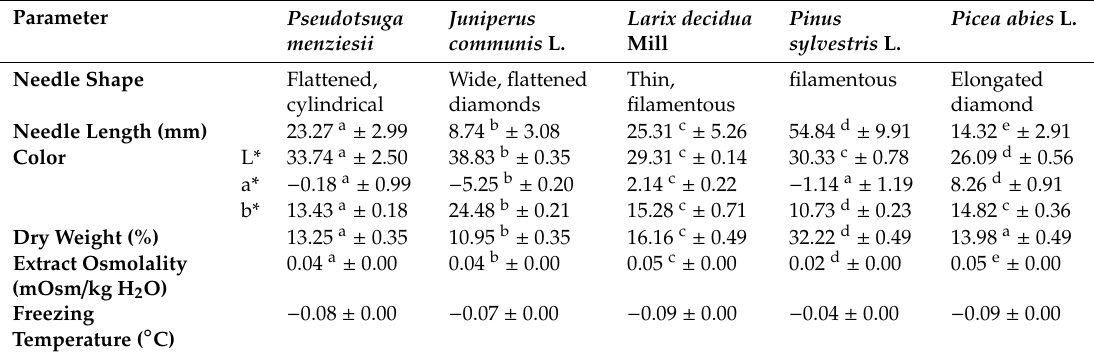
Table 1. Commodity assessment of tested coniferous shoots.